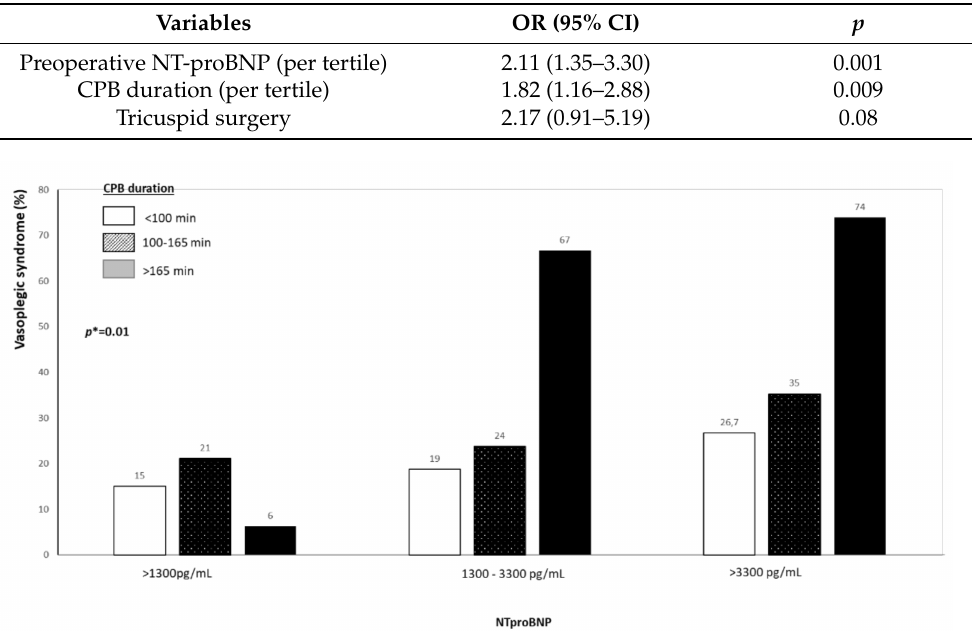
Table 4. Variables independently associated with the risk of vasoplegia (multivariate analysis).